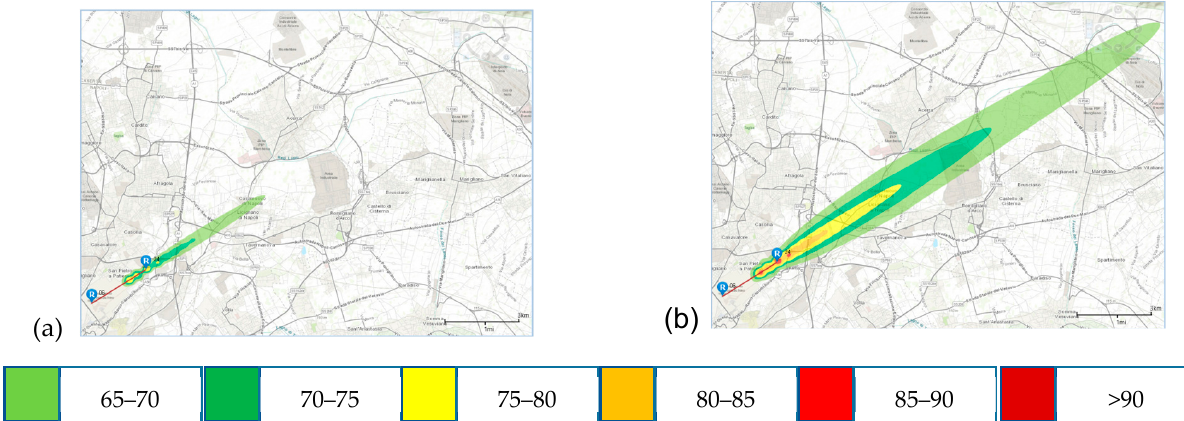
Figure 41. Graphical representation of equal loudness contours for the conventional ( a ) and hybrid ( b ) configurations, in terms of L AE (dB-A), for a standard runway-24 landing.